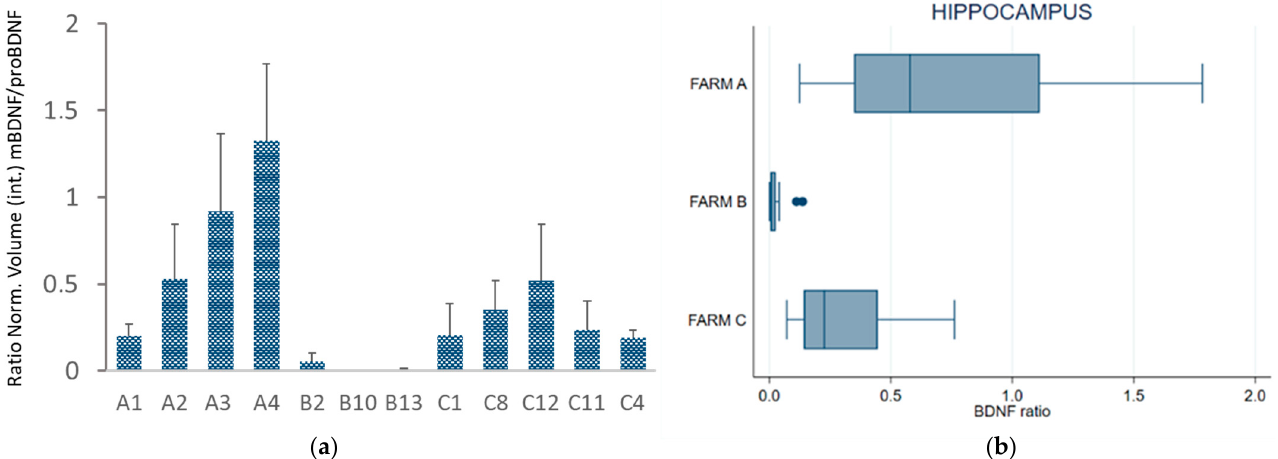
Figure 5. ( a ) BDNF ratio (mBDNF/proBDNF) of normalized volume calculated in the hippocampus; ( b ) box plot of the mBDNF/proBDNF ratio in the hippocampus of the cows grouped by farm. The error bars indicate standard deviation. Individual cows are indicated as: A1, A2, A3, A4 for Farm A; B2, B10, B13 for Farm B; C1, C4, C8, C11, C12 for Farm C.